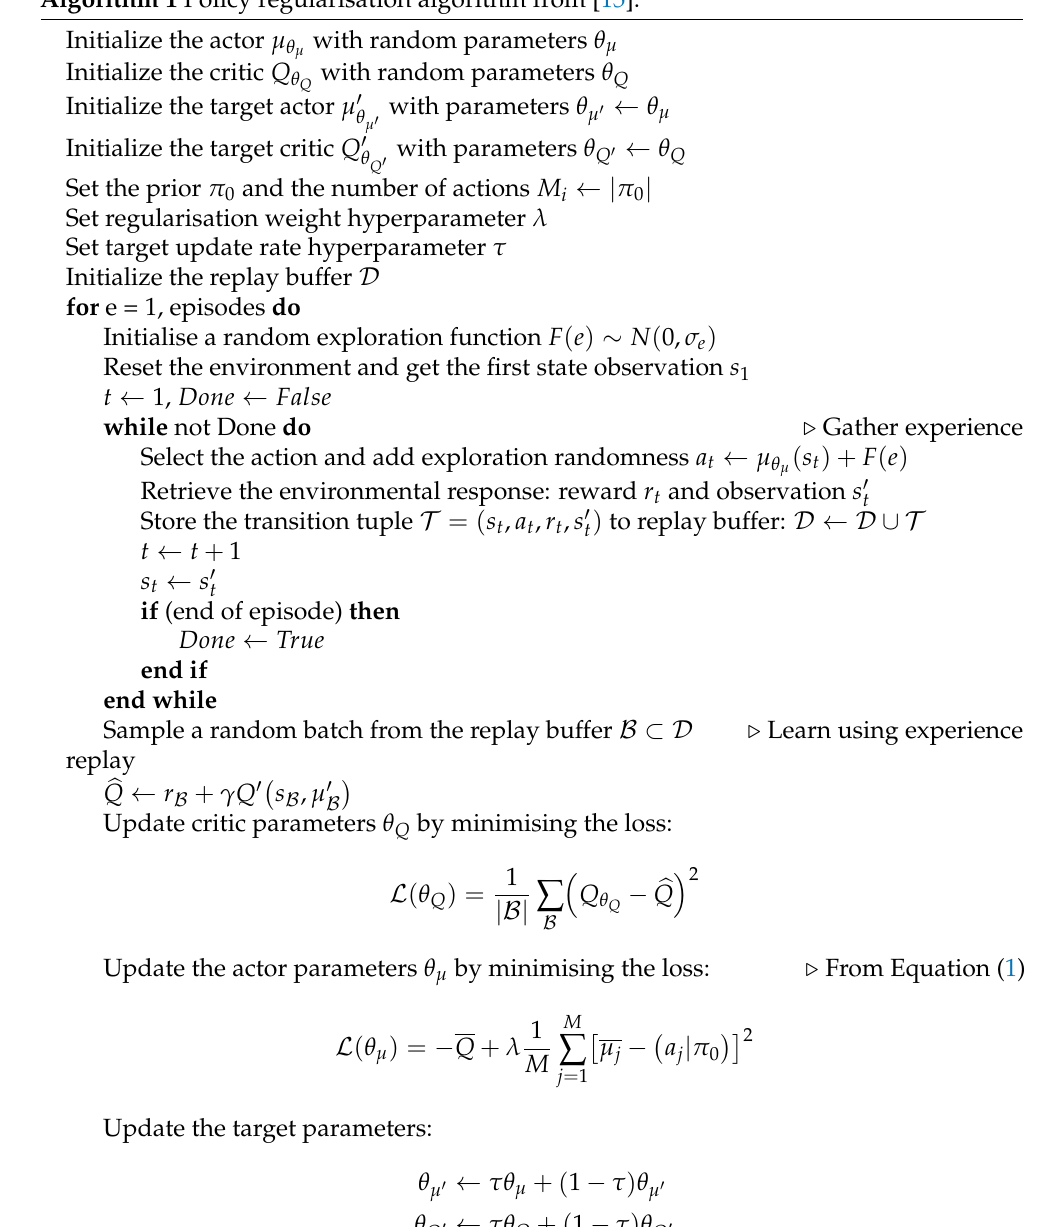
Algorithm 1 Policy regularisation algorithm from